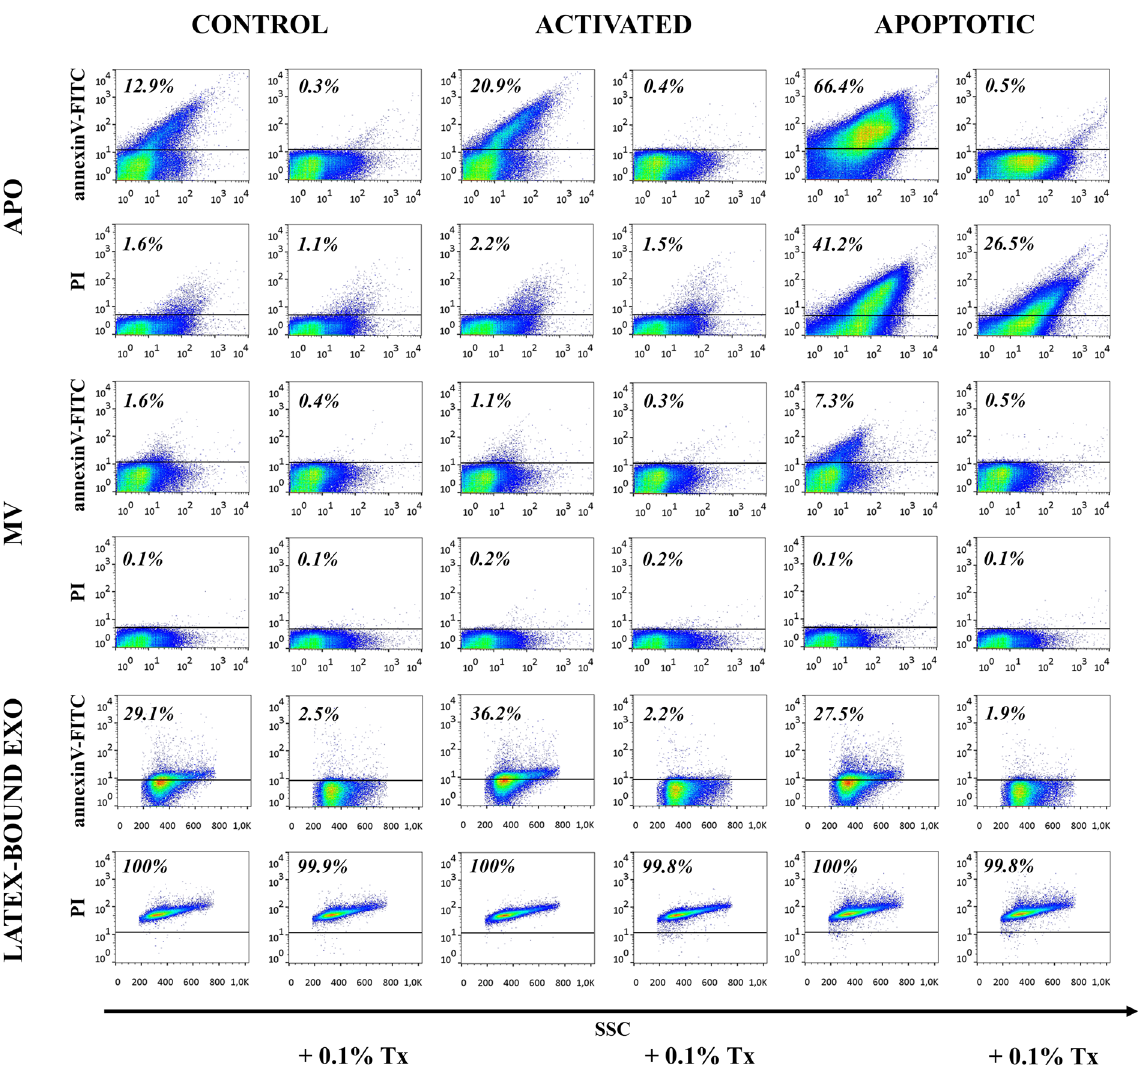
Figure 6. Flow cytometry analysis of extracellular vesicles (EVs) derived from ciprofloxacin-exposed control, activated or apoptotic Jurkat cells. EVs were stained by annexinV-FITC and propidium iodide (PI) for flow cytometry and analyzed before and after detergent lysis with 0.1% Triton X-100. Apoptotic bodies (APOs) and microvesicles (MVs) were labeled and measured directly, whereas exosomes (EXOs) were conjugated onto latex beads before staining. Density plots show annexinV-FITC and PI positivity of EVs derived from ciprofloxacin- exposed control, activated and apoptotic Jurkat cells. The percentages of positive events (above the threshold represented by a black line) are shown in the